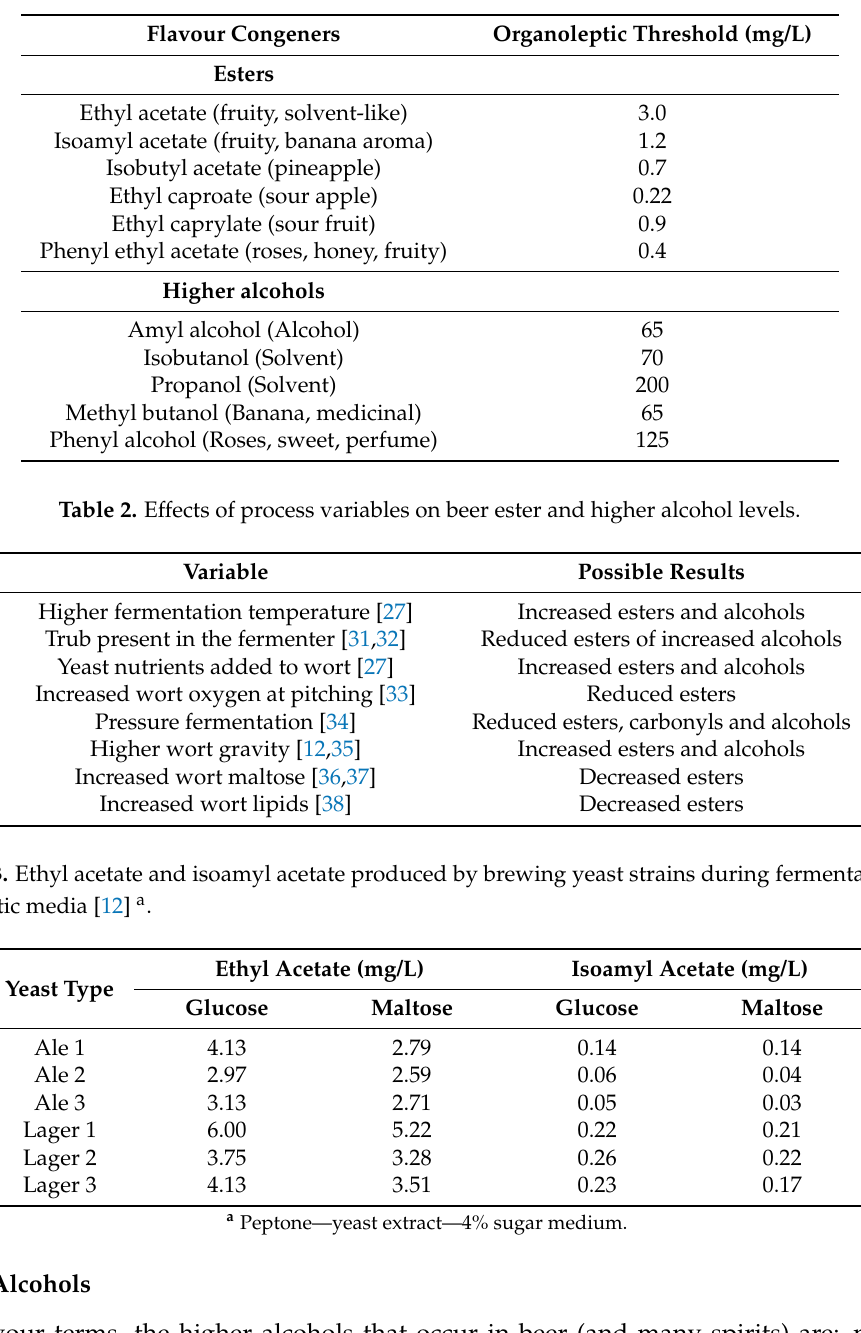
Table 1. Major esters and higher (fusel) alcohols in beer [4].